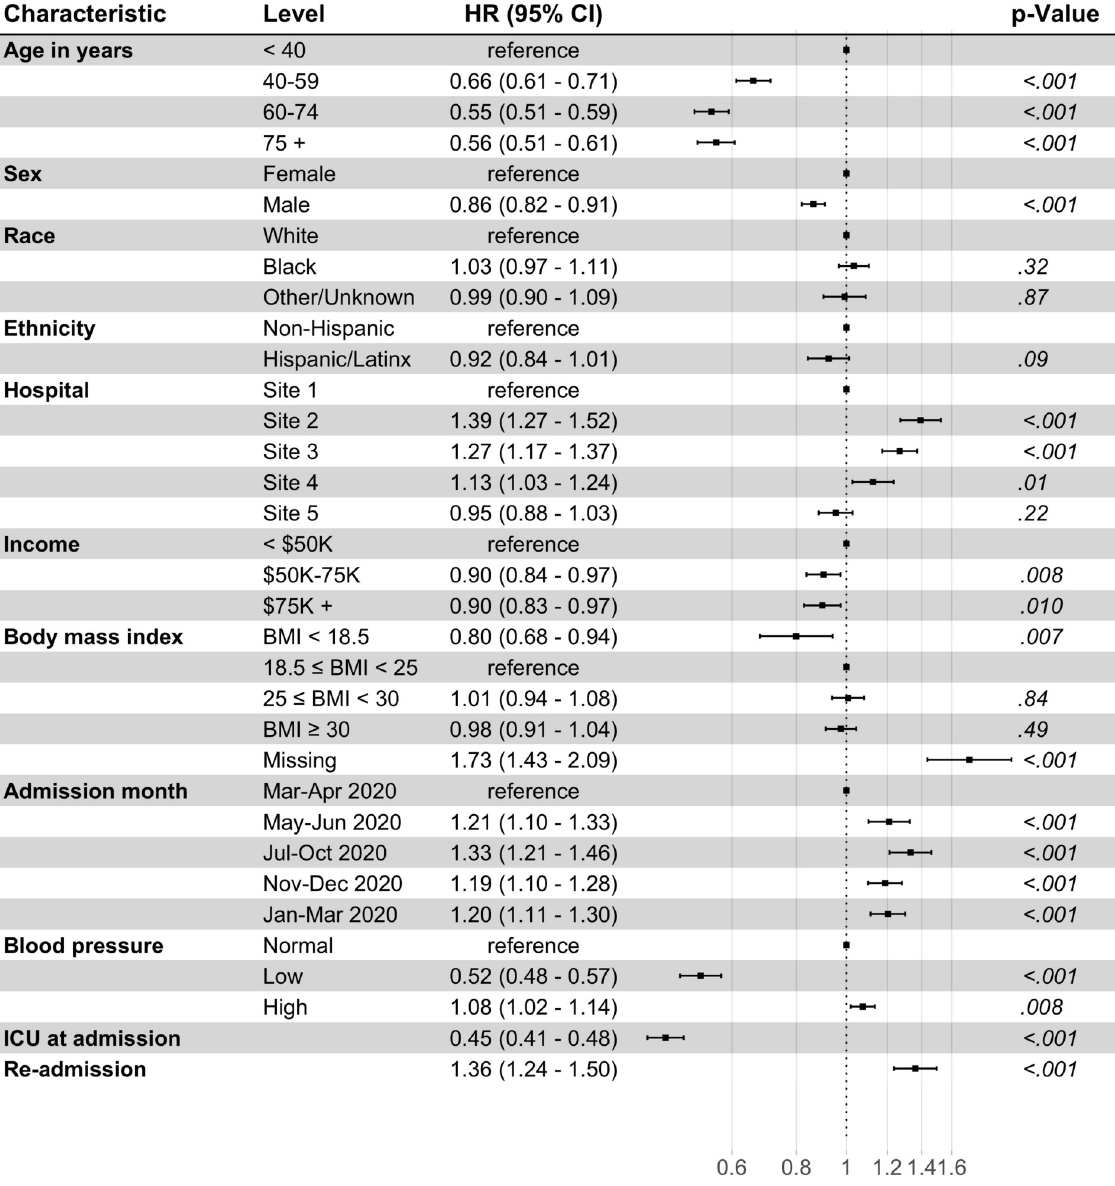
Fig 3. Multi-state multivariable Cox regression model for hospitalization to discharge transition (model 1). N = 6233; 22 observations deleted due to missingness in zip code (15) and blood pressure (7). Site 1 (n = 1762), Site 2 (n = 1048), Site 3 (n = 1030), Site 4 (n = 1163), Site 5 (n = 1252) are unique hospitals in the University of Pennsylvania Health System. Blood pressure, classified as low if systolic blood pressure (SBP) < 90 millimeters of mercury (mm Hg) or diastolic blood pressure (DBP) < 60 mm Hg; otherwise, classified as high blood pressure if SBP > 130 mm Hg or DBP > 80 mm Hg; CI: Confidence interval; ICU, intensive care unit; Income, Median household Income in patient’s 5-digit zip code, as determined by the 2014–2018 5-year American Community Survey ( ACS); HR, hazard